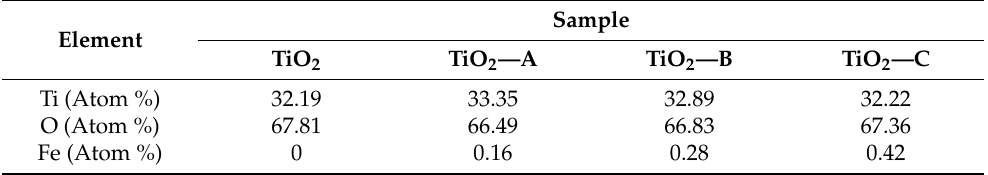
Table 2. Energy dispersive X-ray spectroscopy (EDX) analysis of all samples.